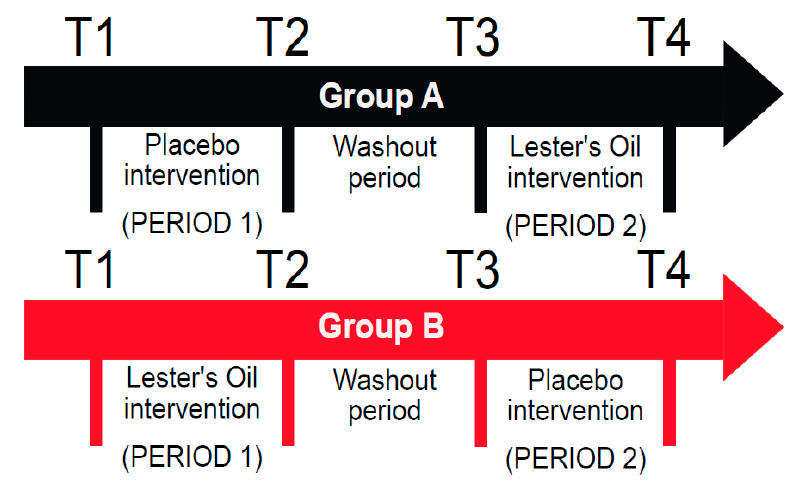
Figure 1. Study Design.